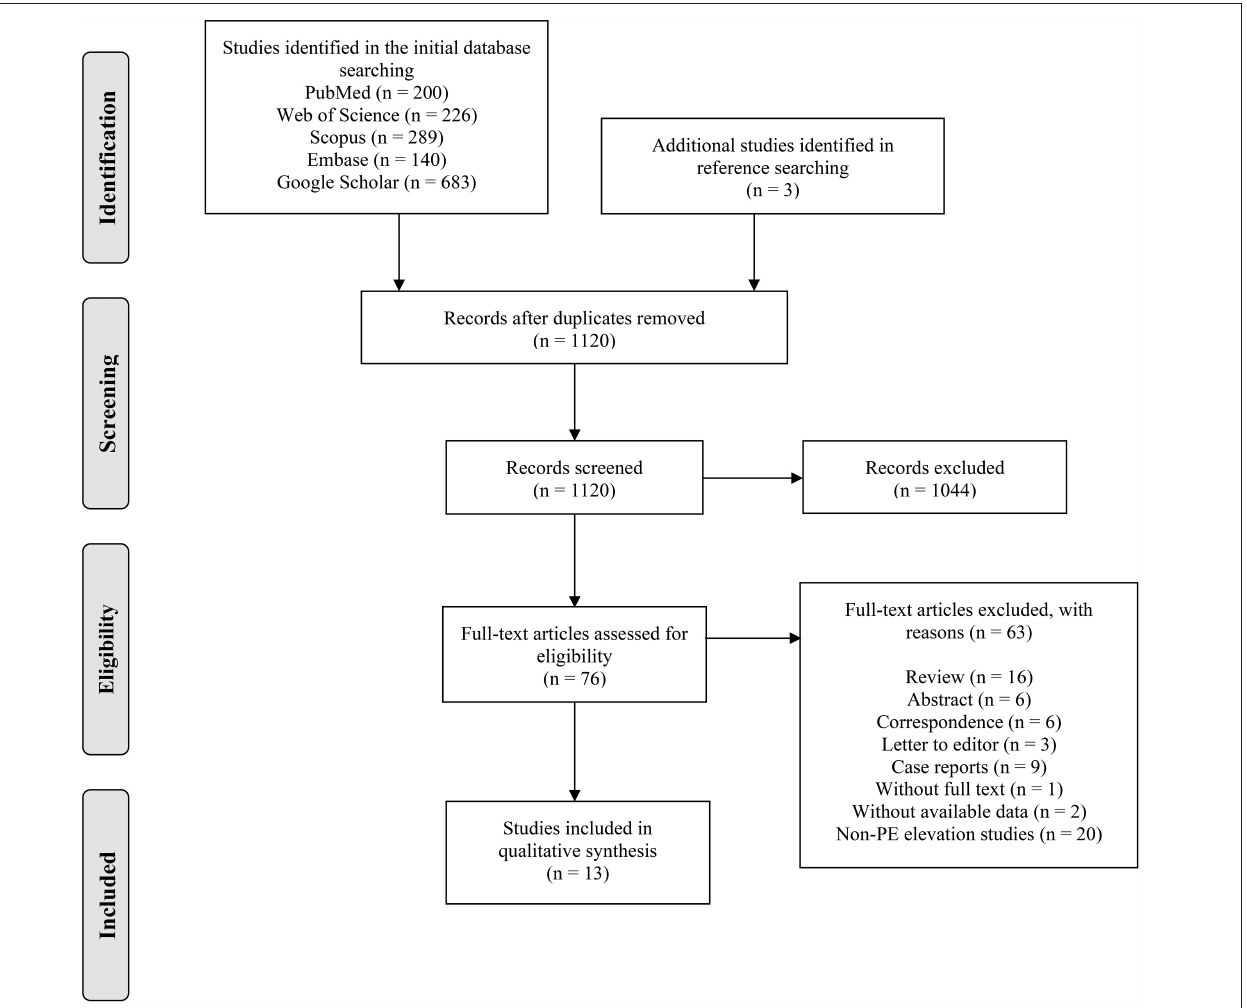
FIGURE 1 | Preferred reporting items for systematic reviews and meta-analyses flow diagram.